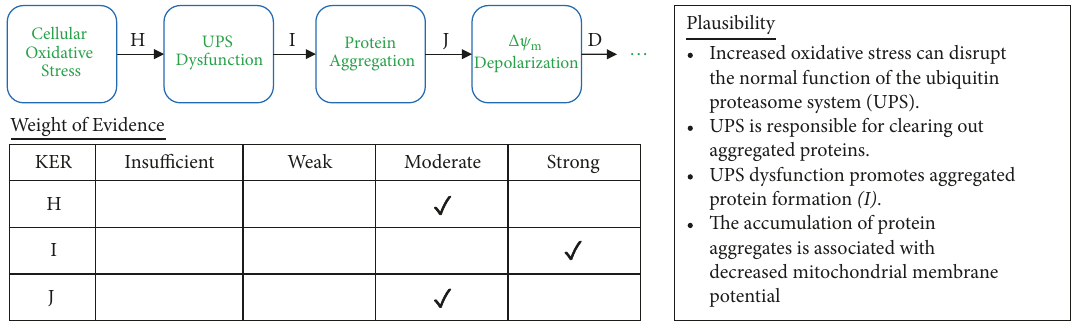
Figure 6: Analyses of Pathway IB. A qualitative assessments of Key Event Relationships (KERs) in the AOP triggered by the generation of reactive oxygen species (MIE) and resulting in mitochondrial disease (AO) via KERs H, I, and